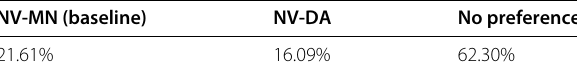
Table 5 Results of AB preference test on vocoders trained with original (NV-MN) and augmented (NV-DA)